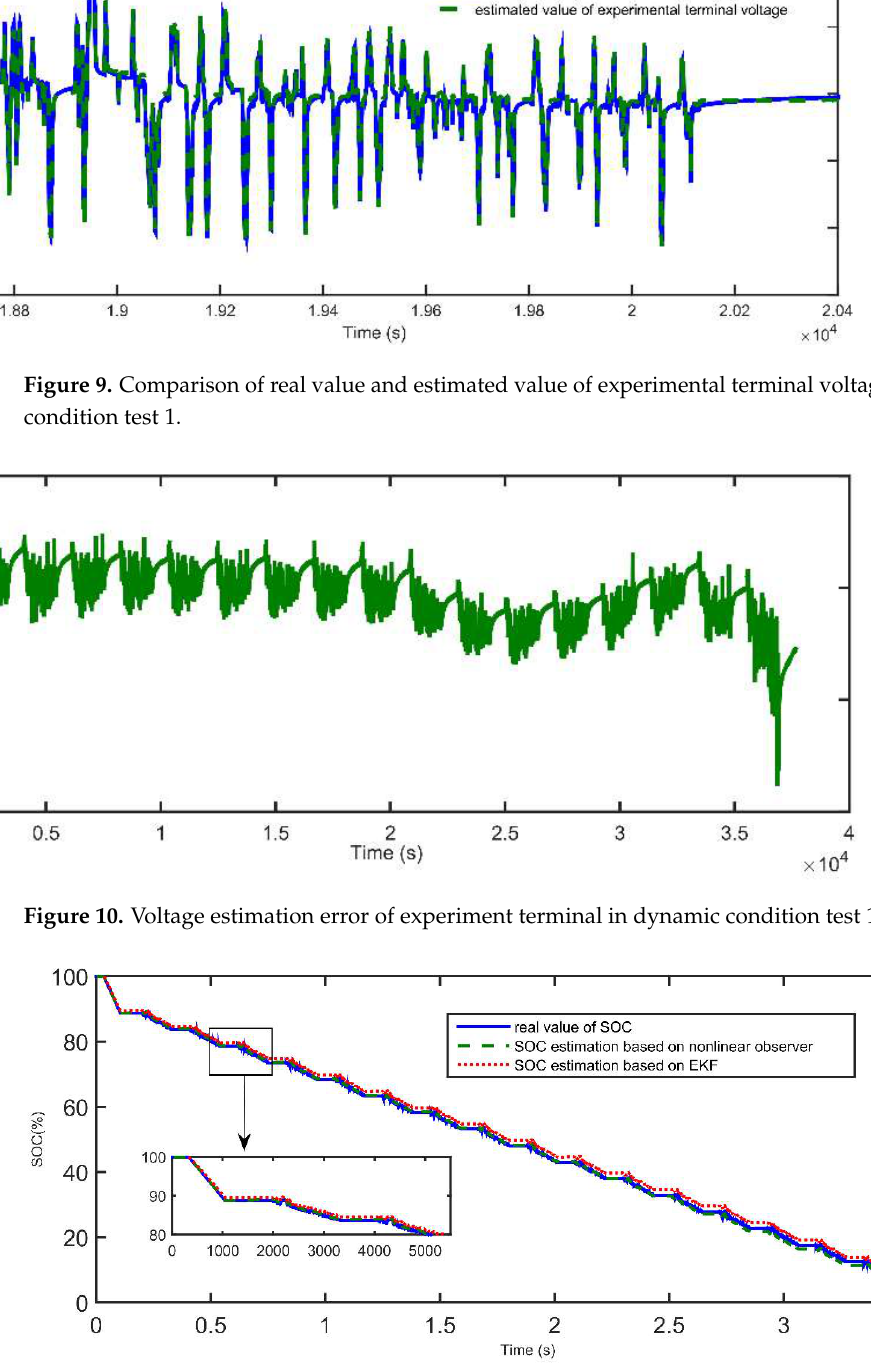
Figure 11. Comparison of SOC estimation based on non-linear observer and EKF in dynamic condition test 1.